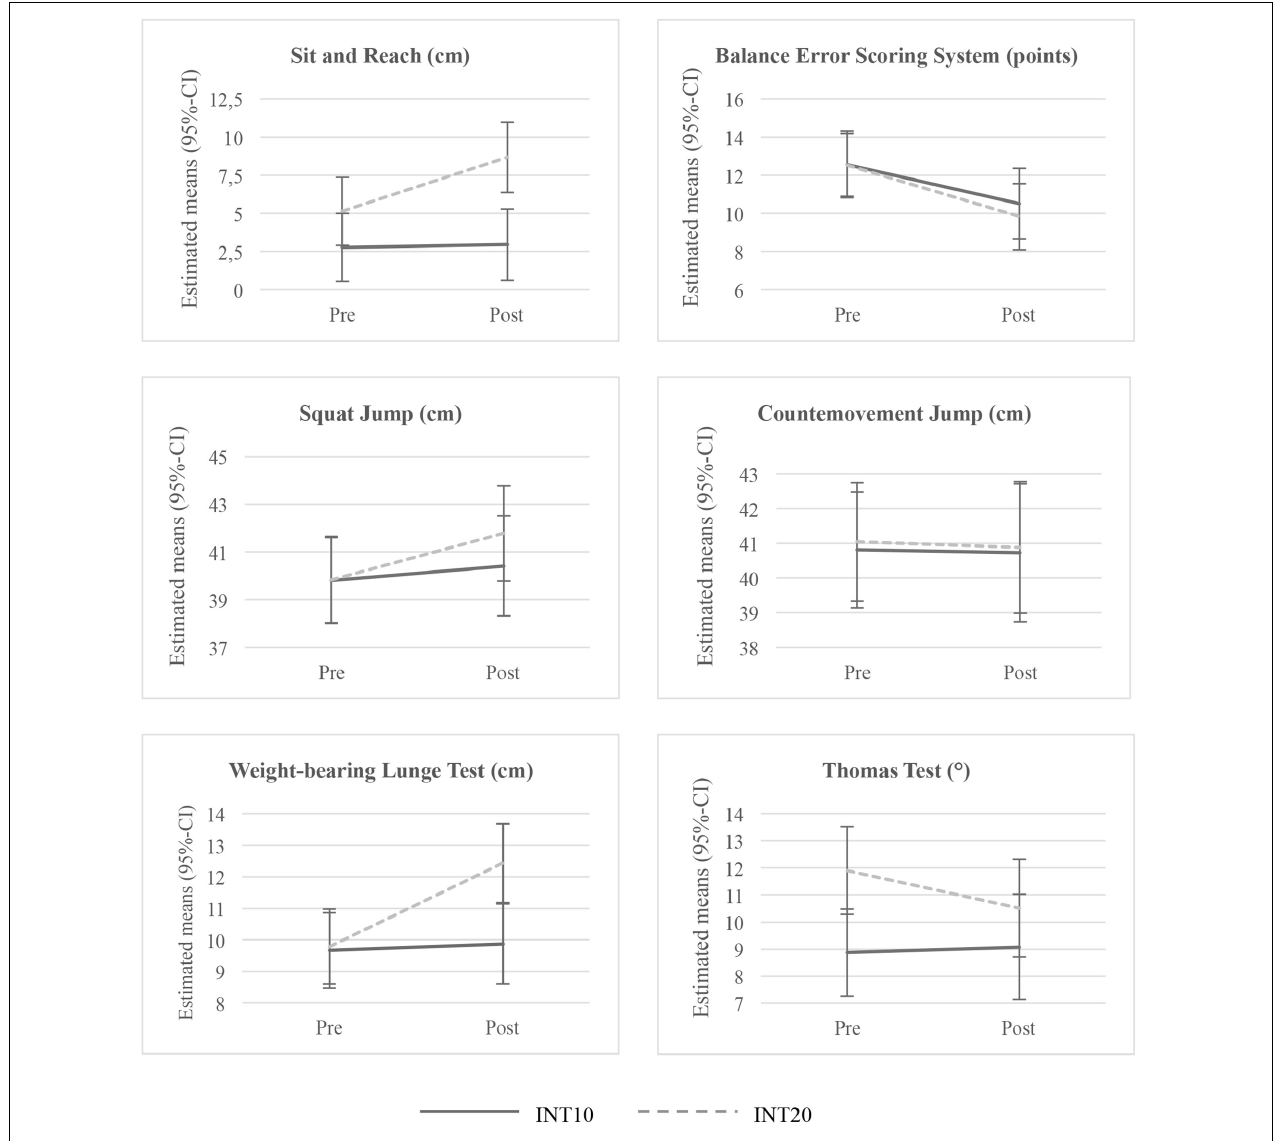
FIGURE 2 | Estimated means and 95%-CI after adjustment for confounders of the two intervention groups for Sit and Reach, BESS, Squat Jump, Countermovement Jump, WBLT and Thomas